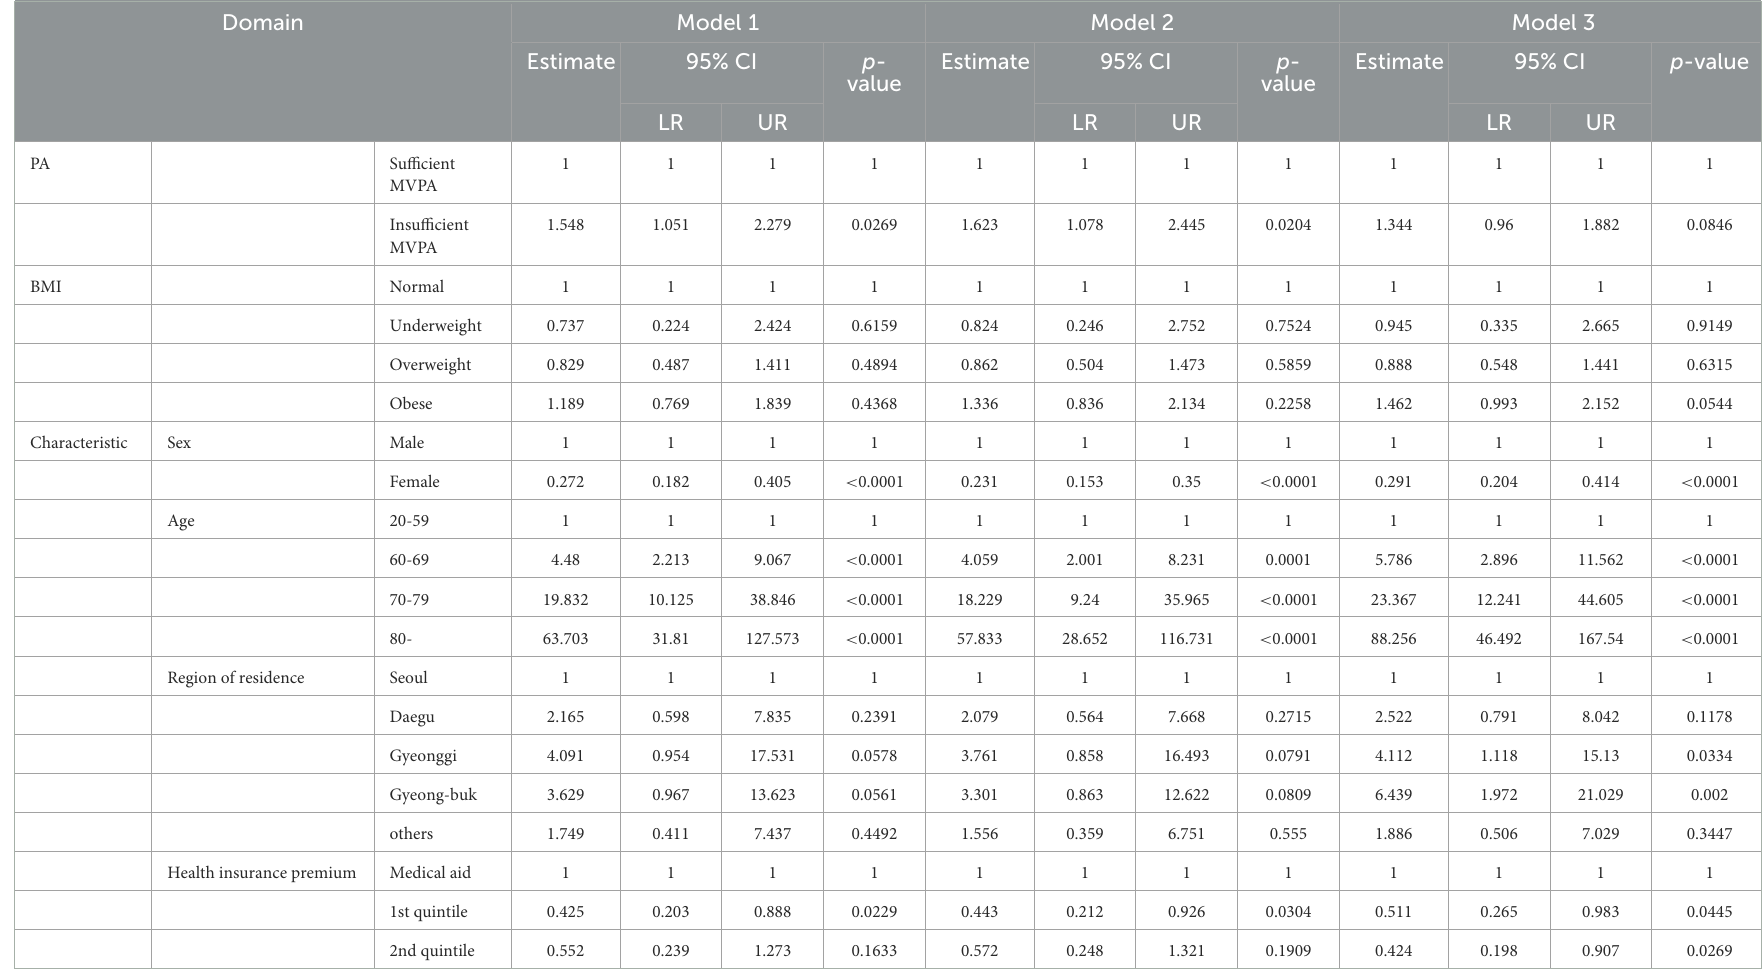
TABLE 3 Results of logistic regression analysis according to COVID-19